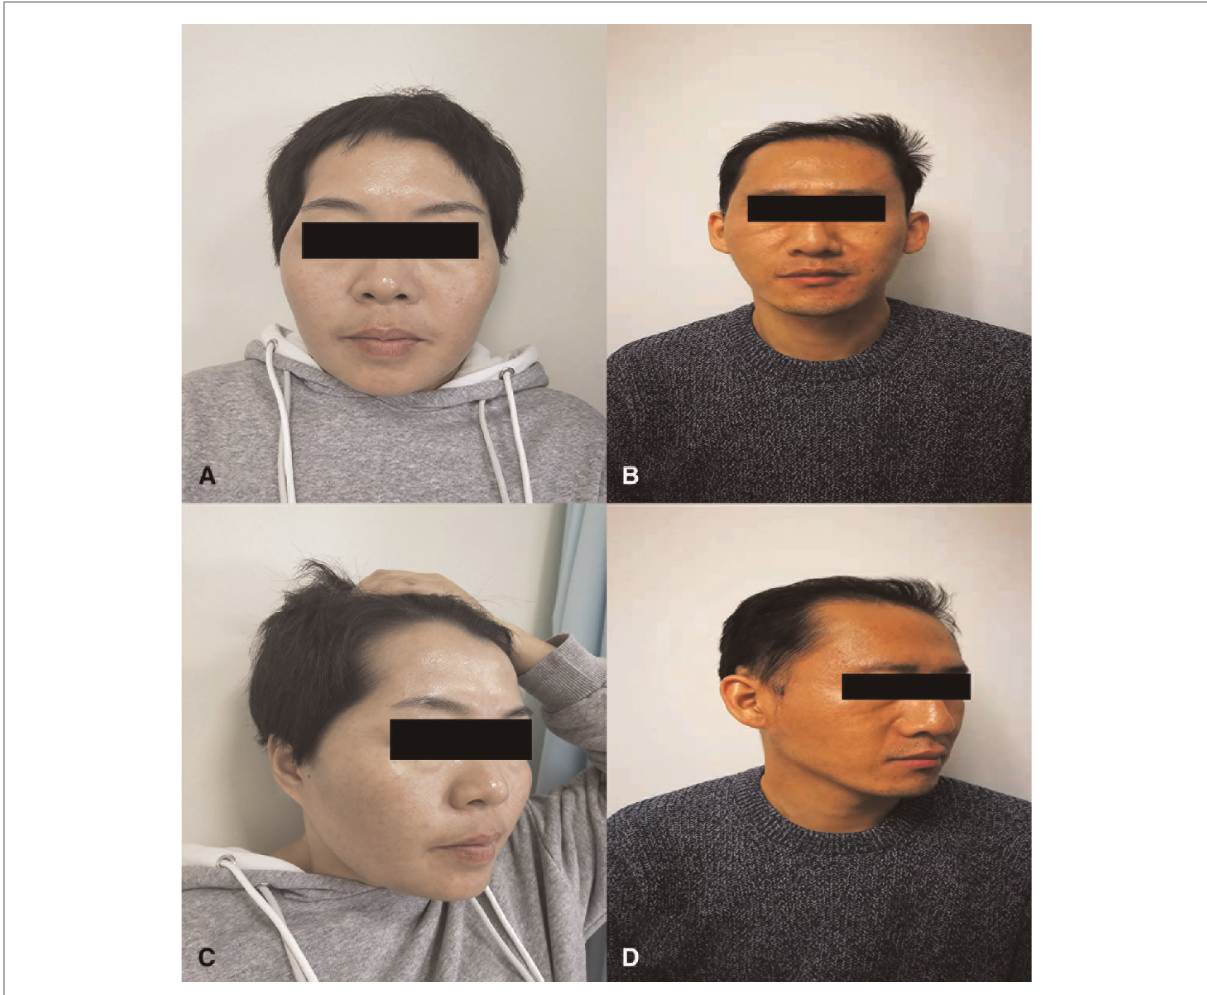
FIGURE 4 Postoperative photographs of the patient. ( A,C ), Patient with hypertrophic temporal muscle and postoperative anteroposterior and lateral views 15 months after temporalis management. ( B , D ), Patients with fl at temporal muscle and postoperative anteroposterior and lateral views 10 months after surgery. The natural contour of their lateral orbital rim and lack of temporal